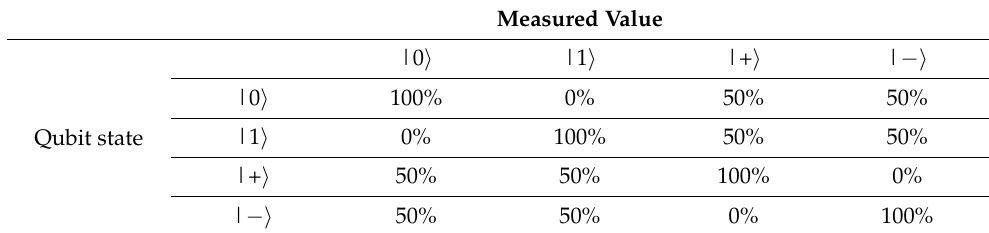
Table 1. The probability of measuring a qubit from one basis state into